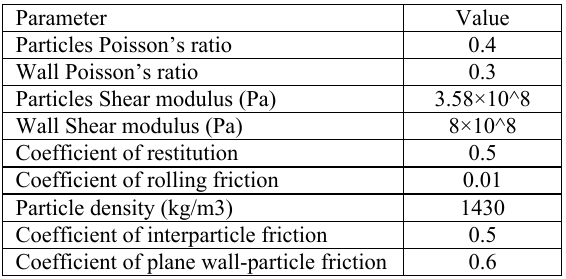
Table 1. The model Micromechanical